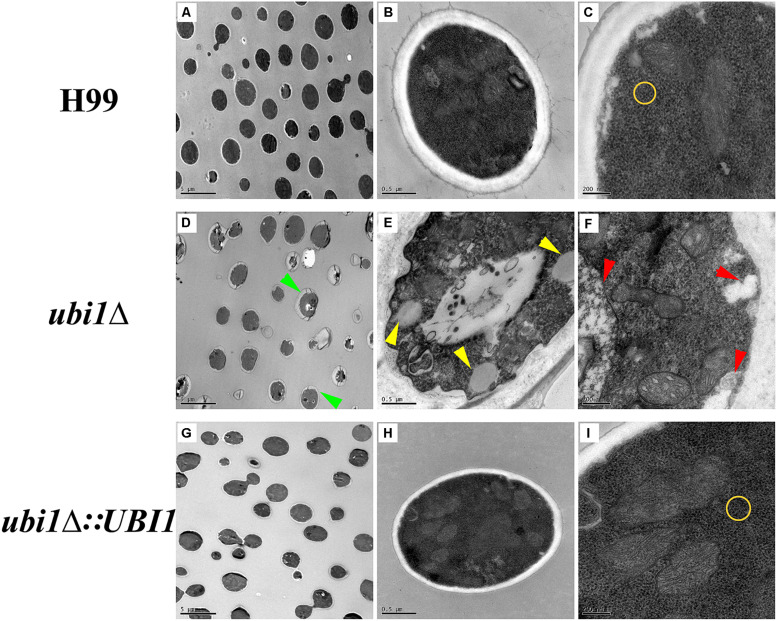
Impact of UBI1 deletion on the cell morphology and intracellular structure of C. neoformans. The TEM images represent different strains as follows, H99 (A–C), ubi1Δ (D–F), and ubi1Δ:UBI1
(G,H). Sizes of the scale bar: 5 μm for (A,D,G); 0.5 μm for (B,E,H); and 200 nm for (C,F,I). Green arrow, irregular cell shape and uneven cell wall thickness; red arrow, swelling mitochondria with dissoluted ridge; yellow arrow, intracellular vacuoles; yellow circle, comparison of ribosomal density.